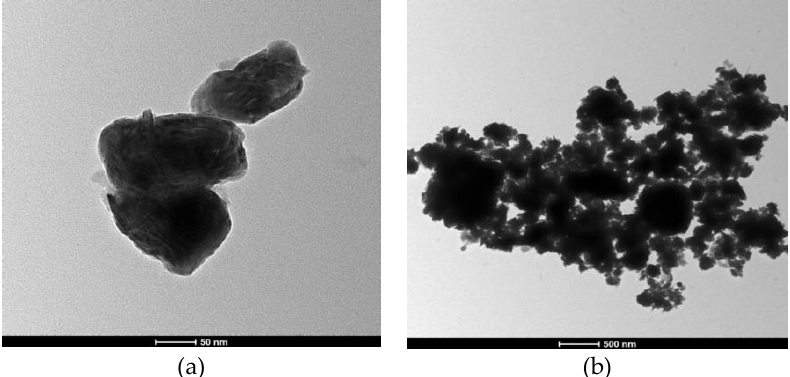
Figure 3. Transmission Electron Microscopy (TEM) with different magnifications of nano-WS 2. ( a ) 50 nm; ( b ) 500 nm.